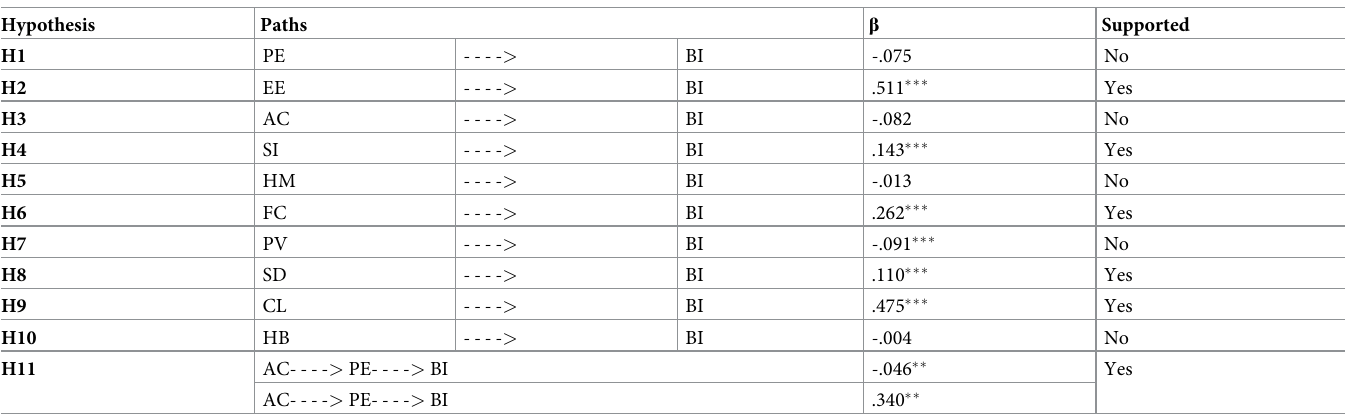
p < 0.01). These hypotheses were supported because independent variables significantly influ- enced (p-value < 0.05) the dependent variable. However, the insignificant path coefficients that did not support the hypothesis included PE and BI (H1); AC and BI (H3); HM and BI (H5); PV and BI (H7); and HB and BI (H10) . 3.4.3. SEM analysis for Pakistan. This section evaluated the hypothesis for the case of Pakistan. Among the hypothesis that were supported by the statistics include: the path coeffi- cient between PE and BI for Hypothesis 1 (H1) ( β = 0.276, p < 0.01); path coefficient between EE and BI for Hypothesis 1 (H2) ( β = 0.517, p < 0.01); path coefficient between FC and BI for Hypothesis 1 (H6) ( β = 0.121, p < 0.01); path coefficient between CL and BI for Hypothesis 1 Table 6. SEM analysis for